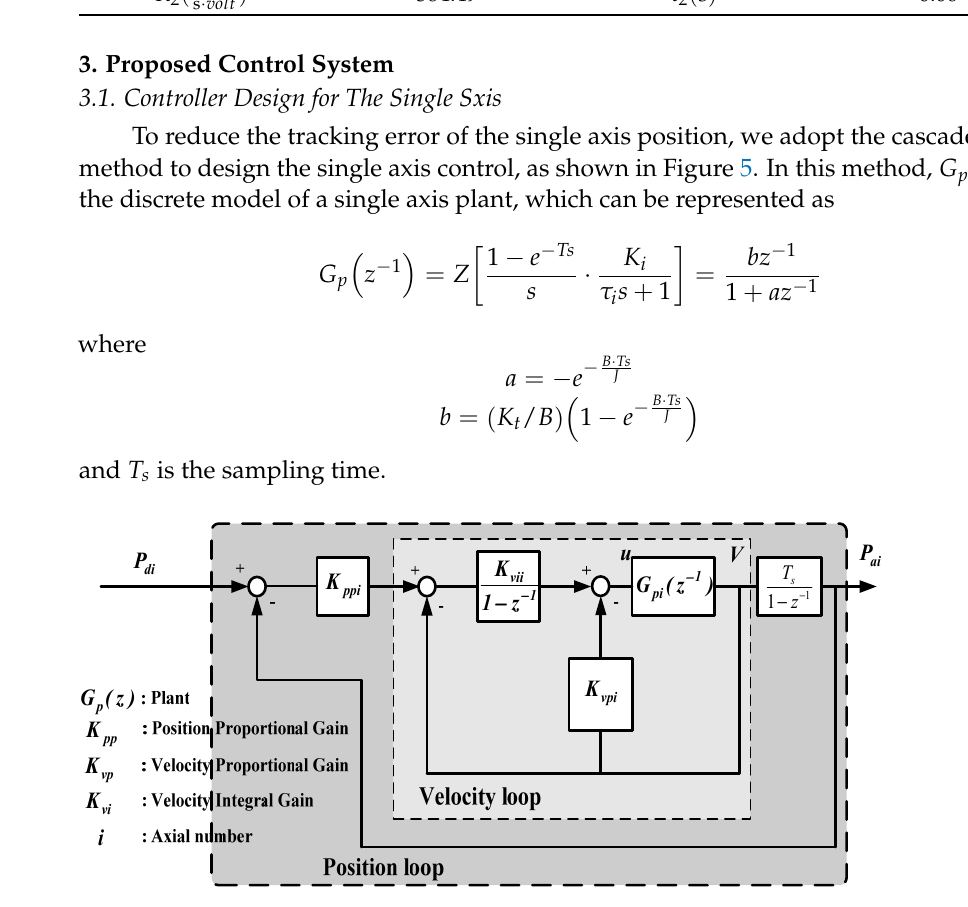
Figure 5. Position loop control of single axis.